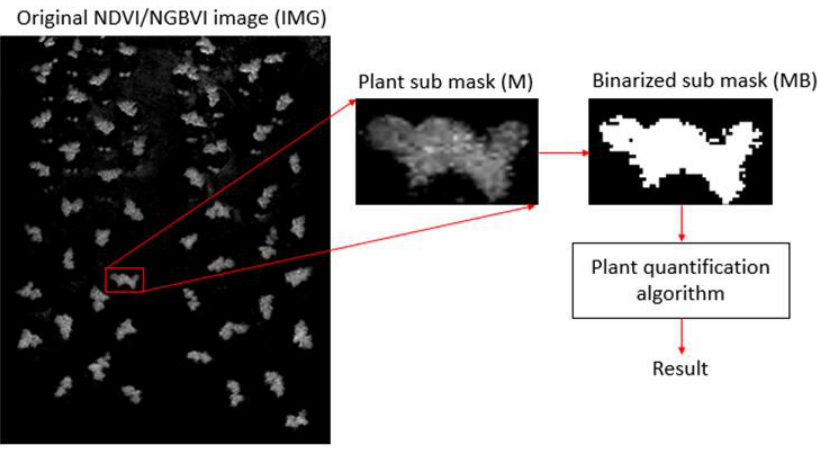
Figure 5. Block diagram for the overall quantification algorithm.